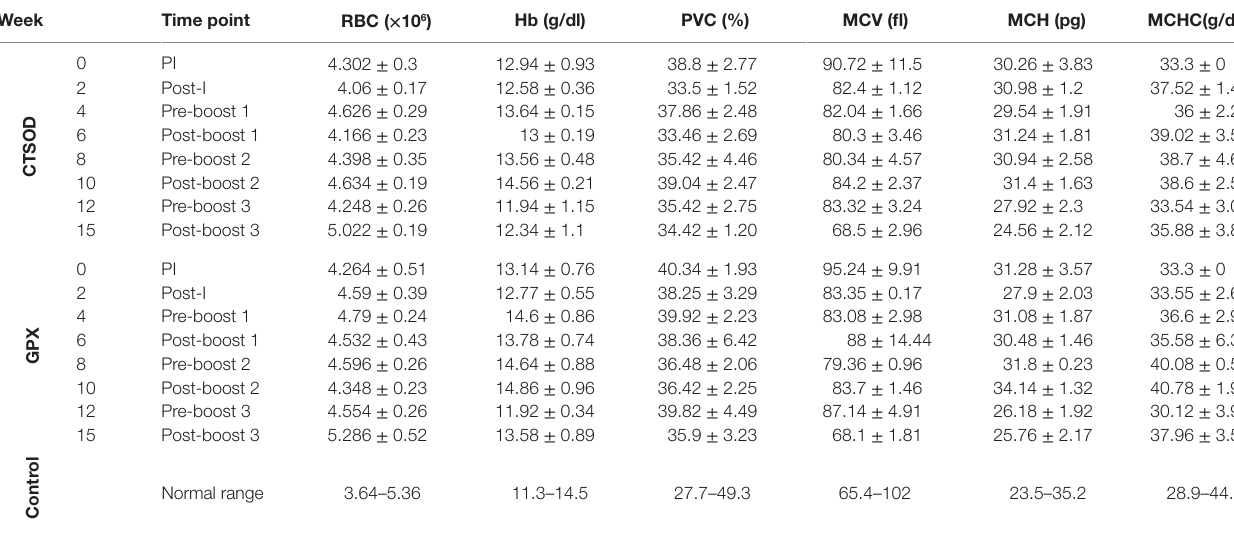
TaBle 2 | summary of effects of vaccination in baboons (experiment 1) a